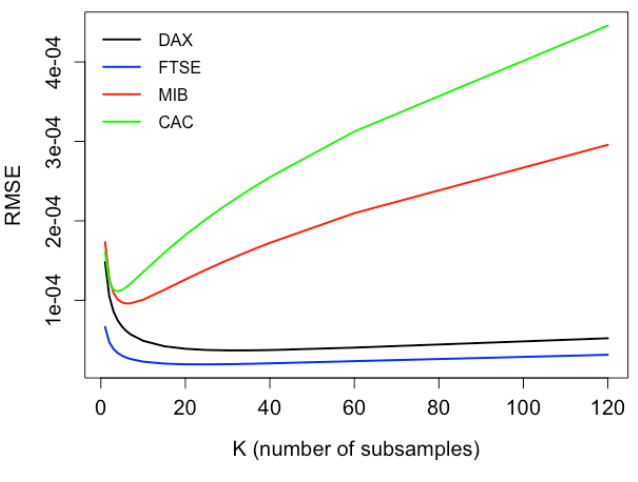
∆ , k , θ with respect to the number t